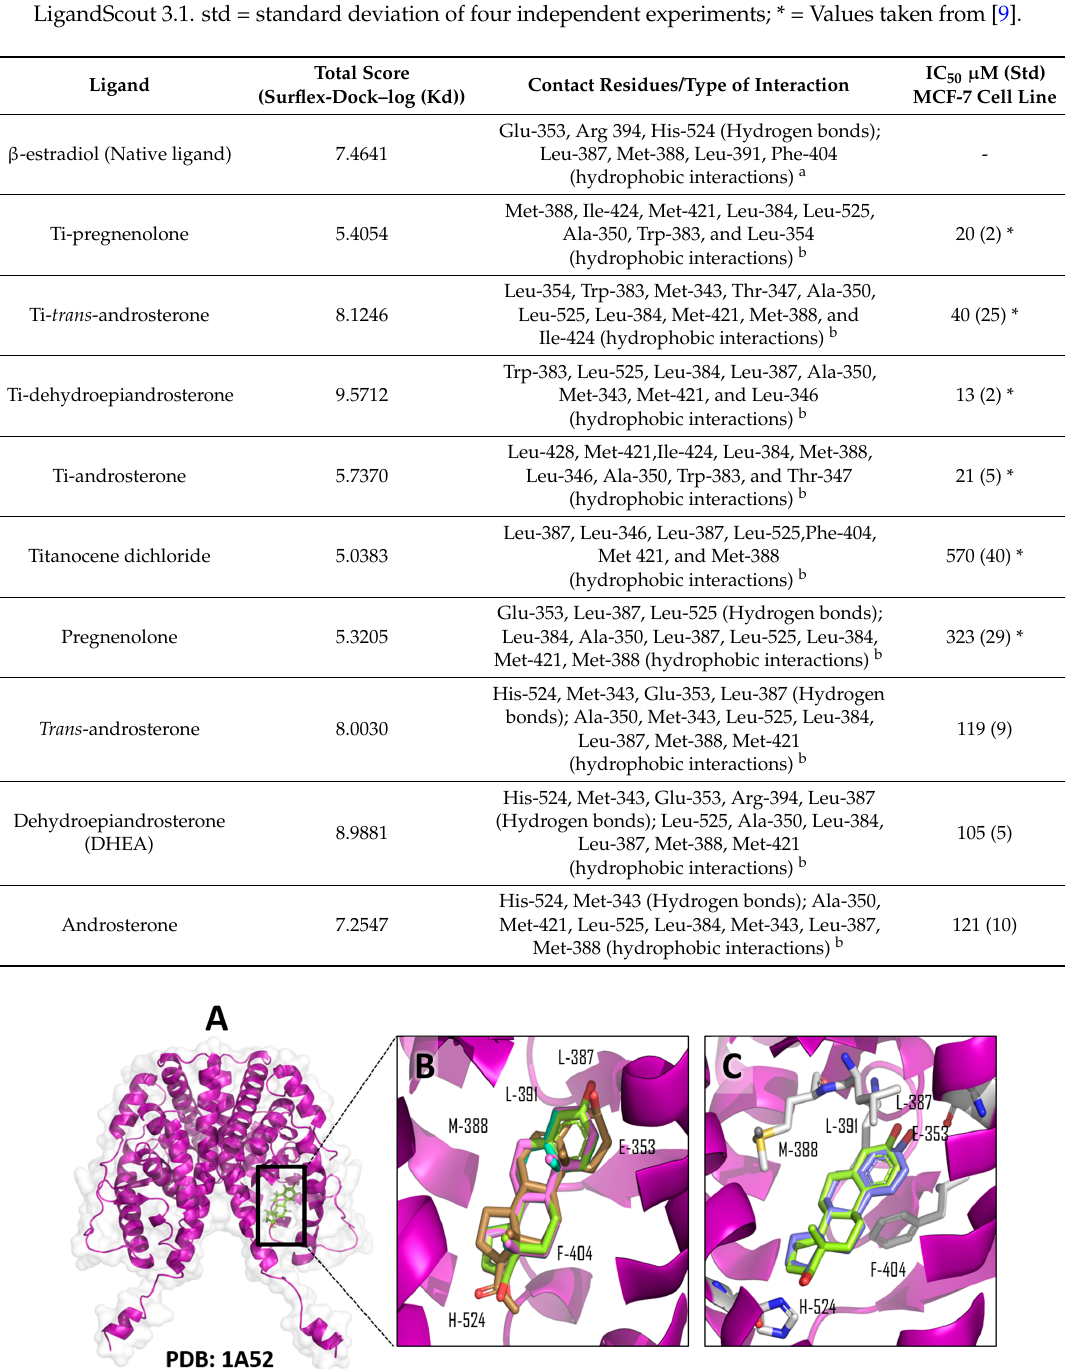
Figure 3. 3D-view estrogen receptor ligand-binding domain (ER α -LBD) - β -estradiol (native ligand) complex ( A ); ER α -LBD- β -estradiol with pregnenolone, dehydroepiandrosterone, androsterone, and trans -androsterone on binding site ( B ). Superimposing of β -estradiol predicted using molecular docking protocols (Surflex-Dock), green and experimental β -estradiol on Protein Data Bank (PDB), blue: 1A52 ( C ).